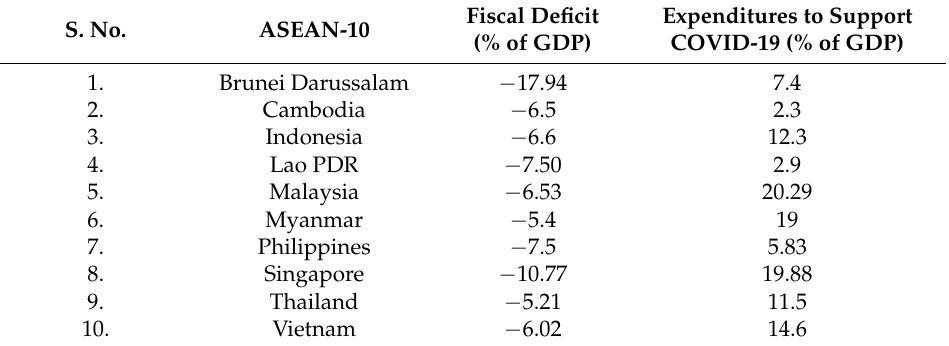
Table 2. ASEAN expenditures to support